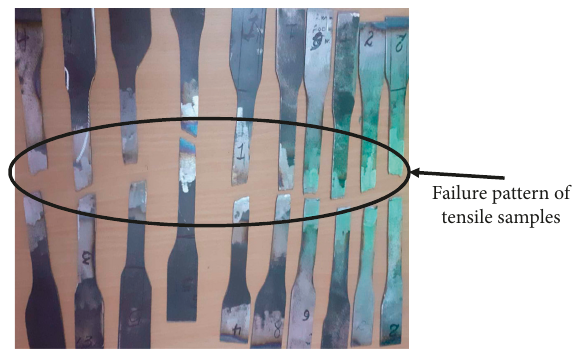
Figure 9: Tensile tested samples. Table 14: Tensile strength reading and signal-to-noise ratio.